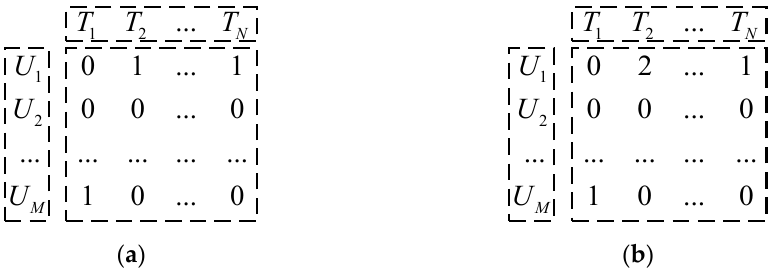
Figure 3. Particle encoding. ( a ) Task allocation matrix. ( b ) Task sequence matrix.